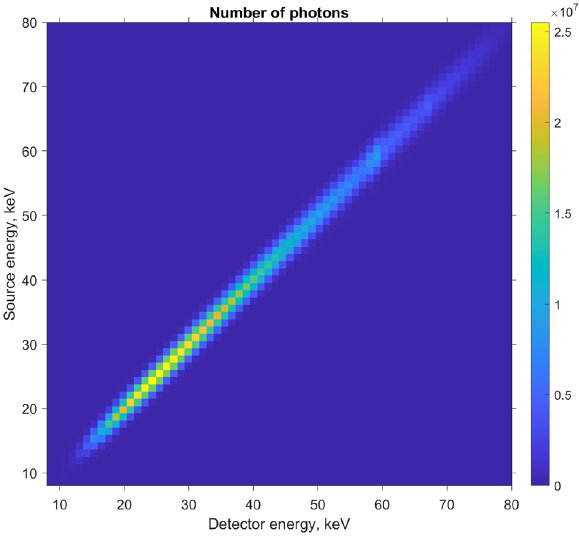
Figure 5. Convolution of detector response with the source spectrum. Due to rapid drop-off away from the diagonal, we use only 5 bins to the left and right to sum over the spectrum (see Eq. (2)), hence 11 terms in total, rather than all